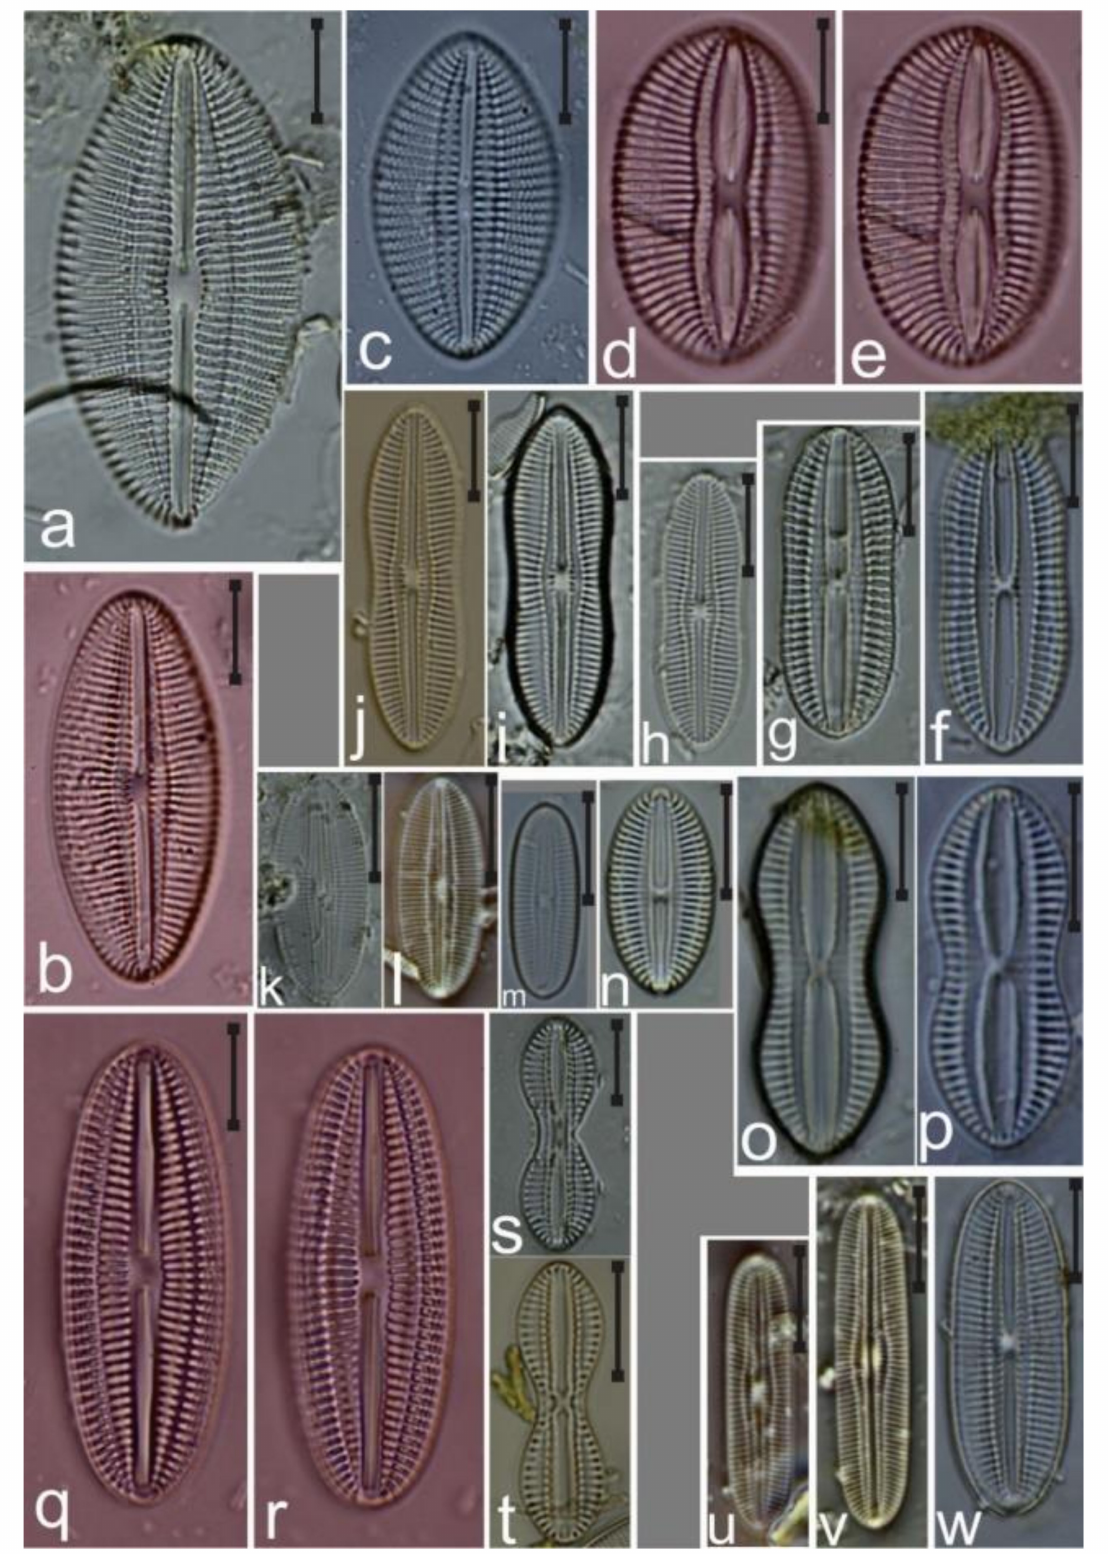
Figure 27. ( a – c ) Diploneis smithii ; ( d , e ) D. suborbicularis ; ( f – j ) D. vacillans var. renitens ; ( k , l ) D. littoralis var. clathrata ; ( m , u , v ) D. vacillans var. vacillans ; ( n ) D. papula ; ( o , p ) D. incurvata ; ( q , r ) D. nitescens ; ( s ) D. novaeseelandiae ; ( t ) D. suspecta ; ( w ) D. littoralis . Scale bar = 10 µ